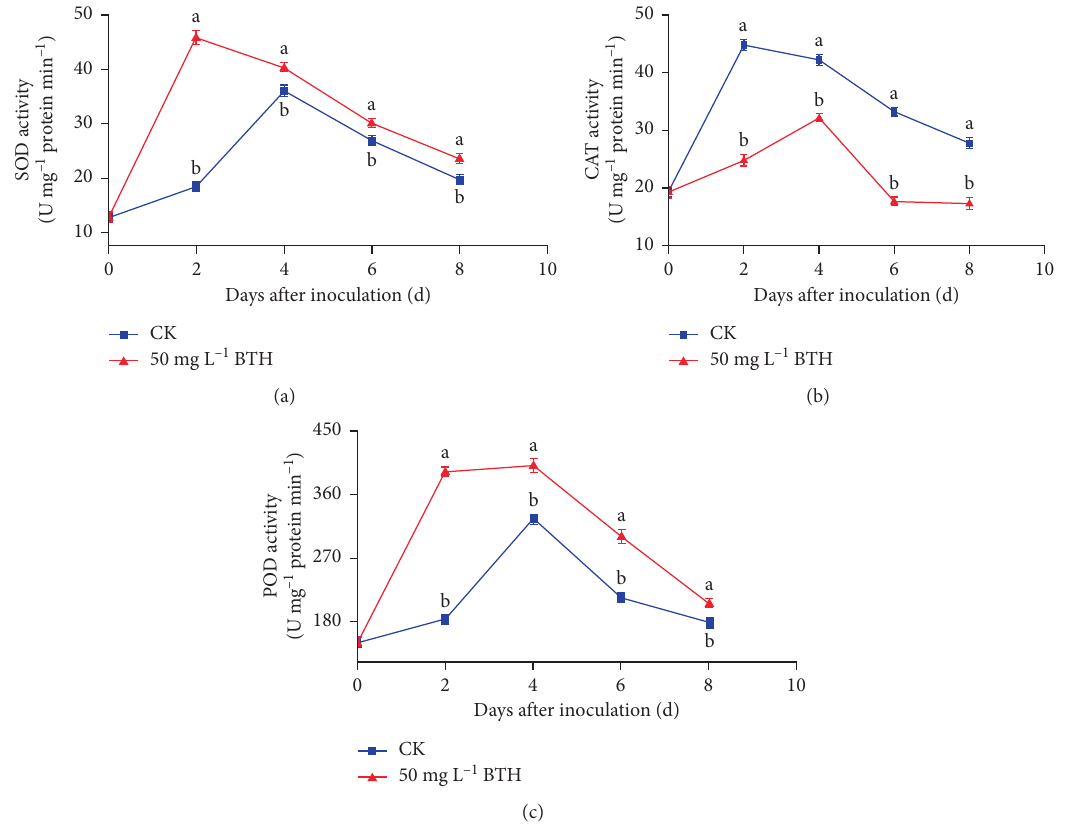
Figure 4: Effects of BTH on the activities of SOD, CAT, and POD of navel orange fruits challenged with P. italicum